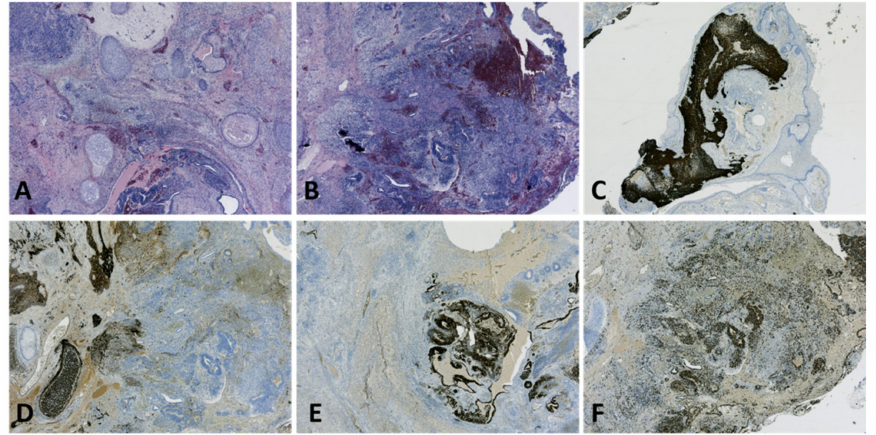
Figure 12. Immature teratoma with neuroectodermal differentiation: ( A ) Teratoid lesion composed of variably dilated glandular lumina with respiratory and digestive type epithelium and bland cartilage islands; immature neural tissue (lower part of the image) (HE, × 25 magnification); ( B ) Extensive (35%) areas of immature neural structures (neuroectodermal tubules and rosettes): immature ter- atoma with neuroectodermal differentiation, high grade (G3) (HE, × 25 magnification); ( C ) GFAP immunohistochemical staining in immature neuroectodermal areas, a lack of reaction in mature teratoid elements ( × 25 magnification); ( D ) S100 immunohistochemical staining in mature neural structures and cartilage islands, a weak focal reaction in immature neuroectodermal areas; lack of reaction in mature teratoid elements ( × 25 magnification); ( E ) Sall4 immunohistochemical staining in immature neuroectodermal areas, a lack of reaction in mature teratoid elements ( × 25 magnifica- tion); ( F ) Increased mitotic activity in immature neuroectodermal areas (Ki67, × 25 magnification). (Courtesy of Dr. M.